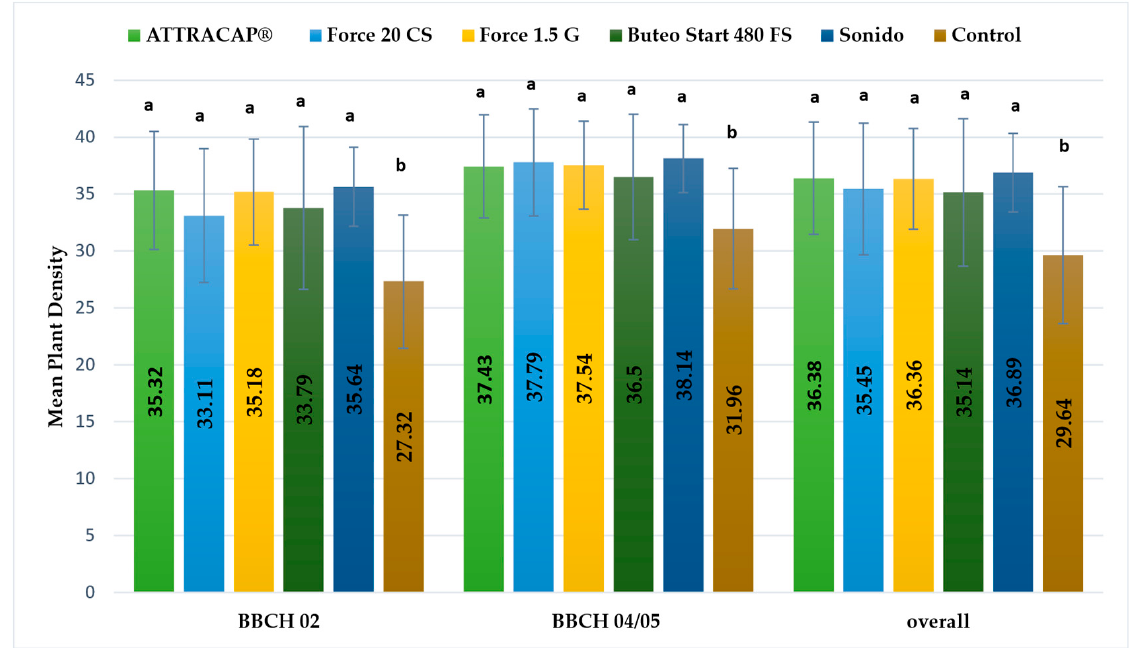
Figure 2. Plant density depending on the insecticidal treatment in 2019.